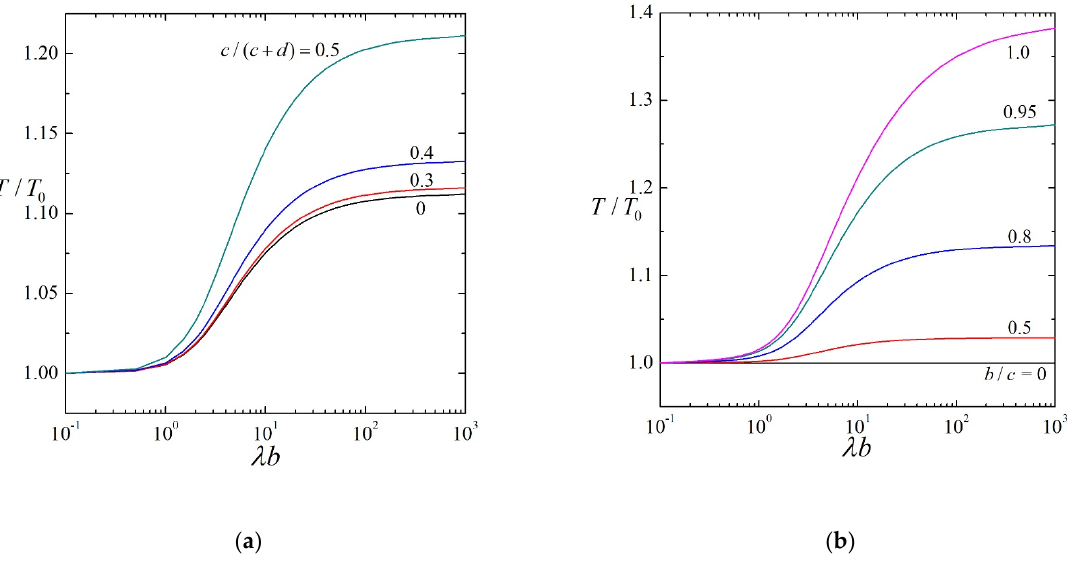
Figure 2. Normalized torque T / T 0 for a porous sphere ( a = 0) rotating about a diameter perpendicular to two planar walls vs. the shielding parameter λ b : ( a ) b / c = 9/10; ( b ) c / ( c + d ) = 1/2.